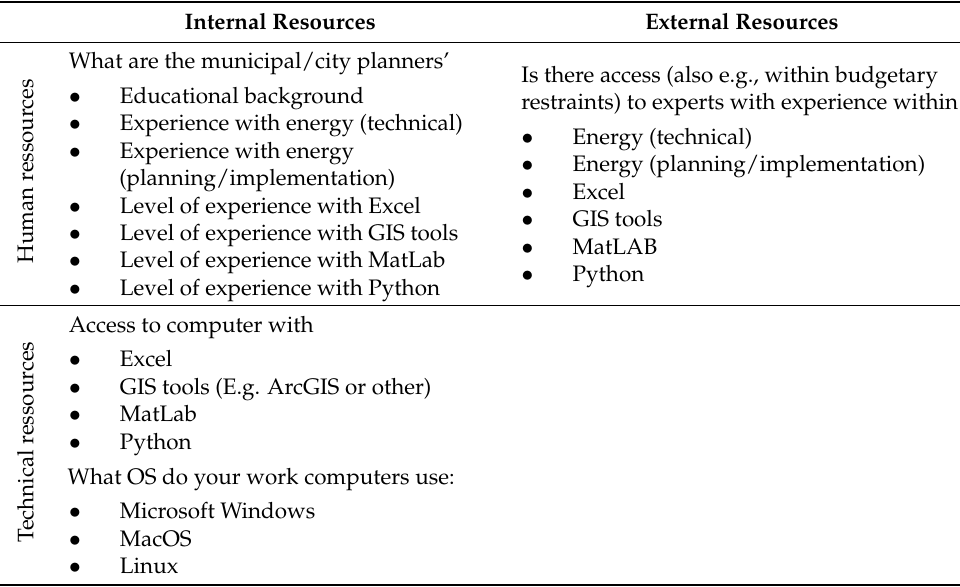
Table A1. Categorisation of municipal energy planning